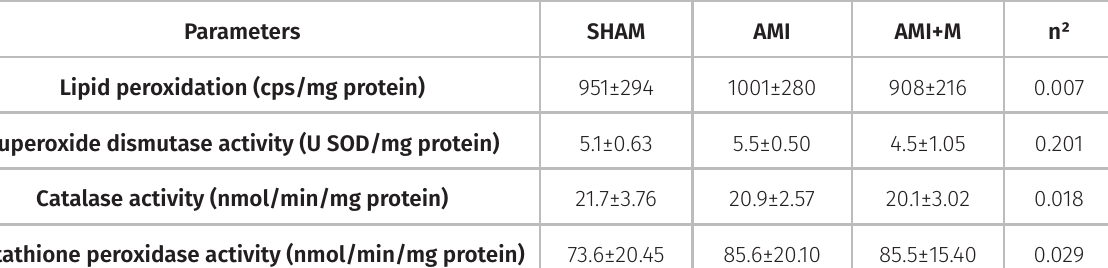
Table III. Oxidative stress data in the cardiac tissue 56 days after the surgery.